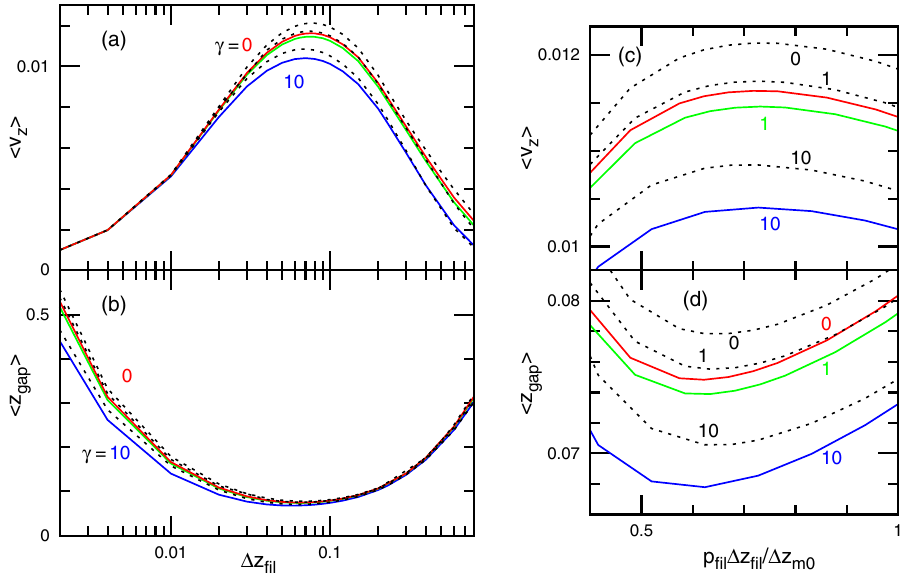
z gap v z Figure 3. Mean growth velocity and mean distance between the membrane and filament tips . In (cid:31) (cid:30) (cid:31) (cid:30) 0 , 1, and 10. The solid and dashed lines (a) and (b), these quantities are plotted as a function of (cid:31) z fil for γ = represent the data in cases I (tension constraint) and II (area constraint), respectively. In ( c ) and ( d ), the data around the maximum velocity and minimum distance are enlarged, and the mean filament growth distance p fil (cid:31) z fil normalized by the mean distance (cid:31) z m0 of the membrane motion at one MC step. The error bars are smaller than the line